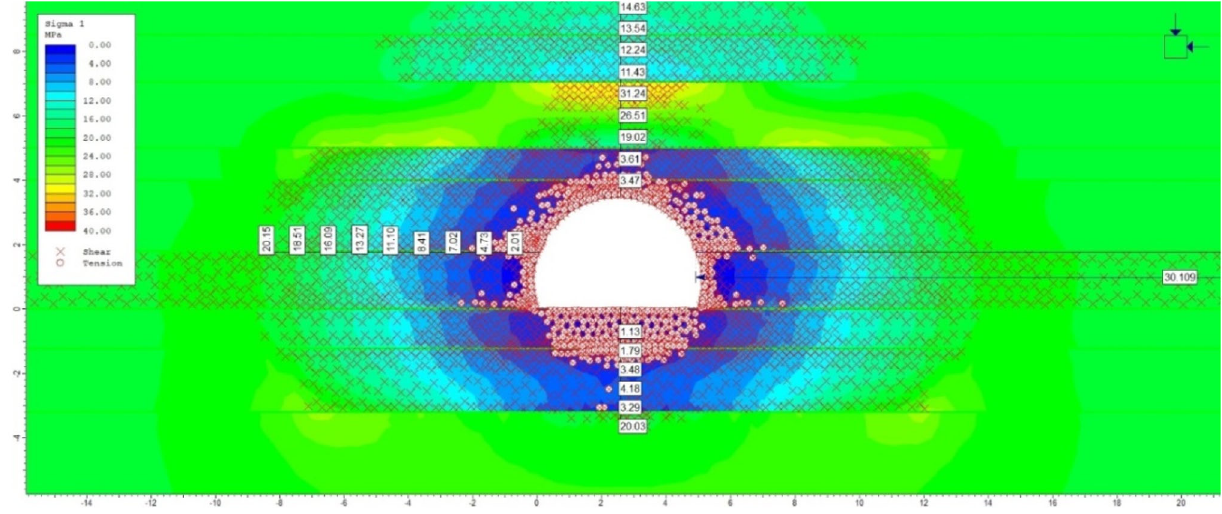
Fig. 12 Major principal stress r 1 with yielded elements of Case